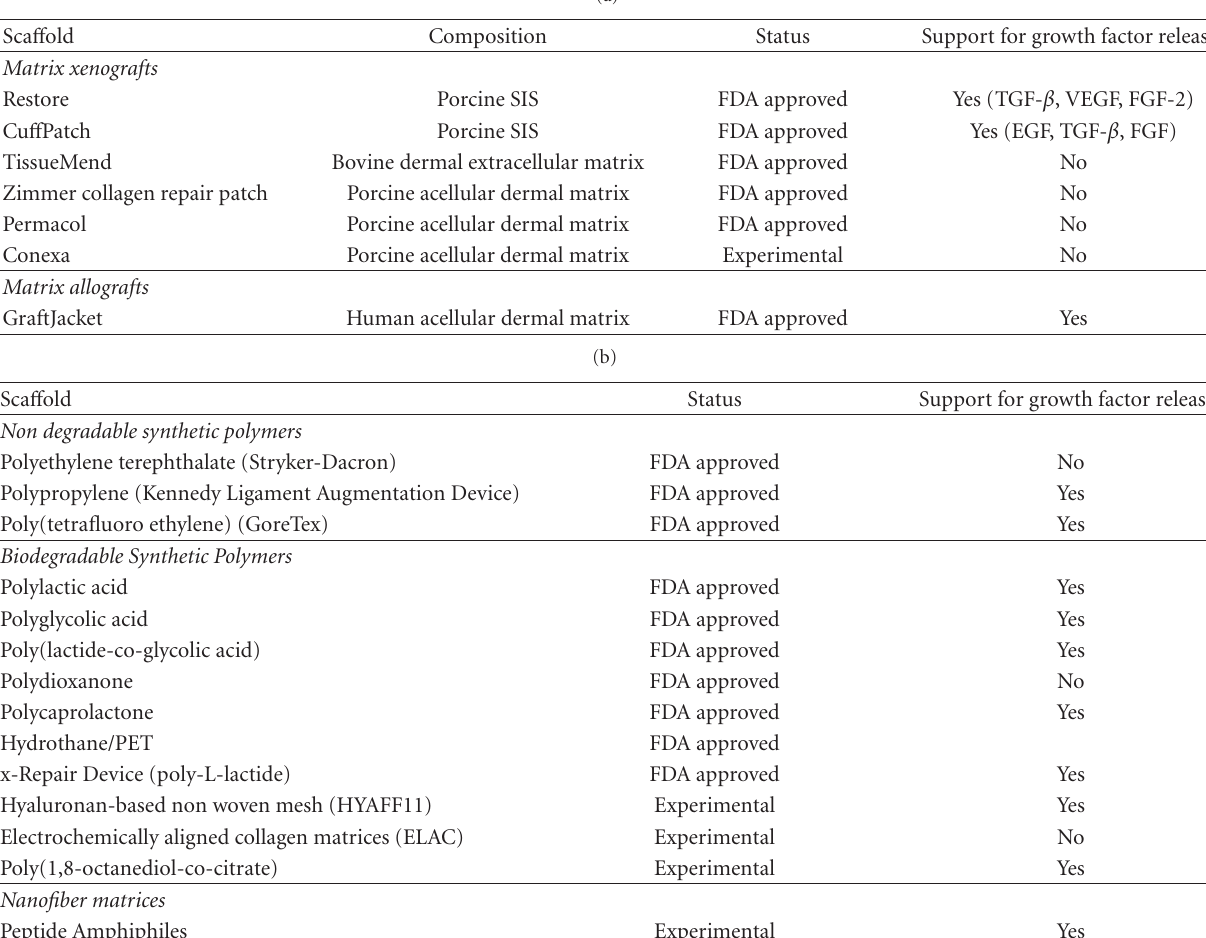
Table 2: (a) Dermal sca ff olds for tendon and ligament augmentation. (b) Synthetic sca ff olds for tendon and ligament augmentation. (a)